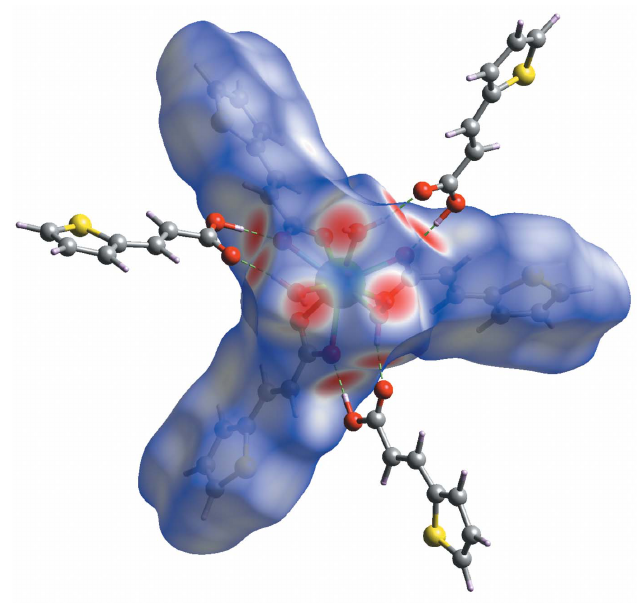
Figure 5 Hirshfeld surface mapped over d norm of the title compound 1 , highlighting the O—H (cid:2)(cid:2)(cid:2) O